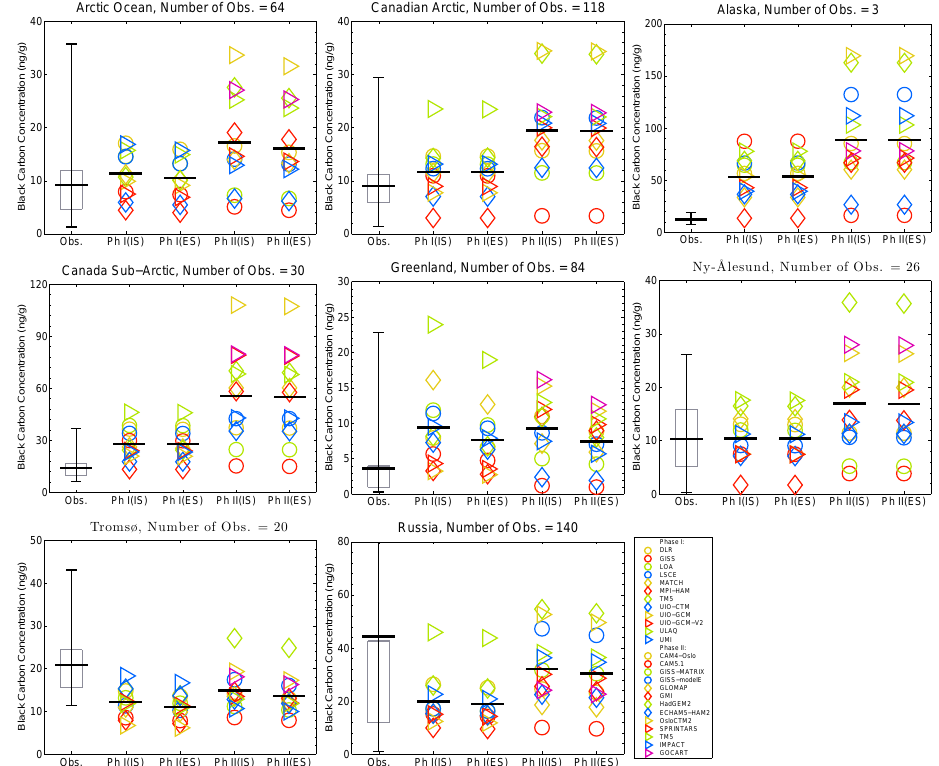
Fig. 11. Same as Fig. 1, but plotted for 8 individual regions. The number of observations within each region is listed in the figure titles. impacts in different regions, reflecting differing degrees